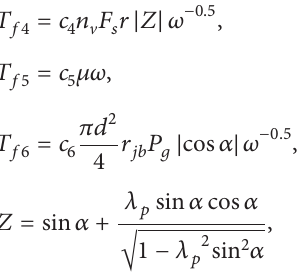
Figure 3: Force analysis of the crank and connecting rod mecha- nism.